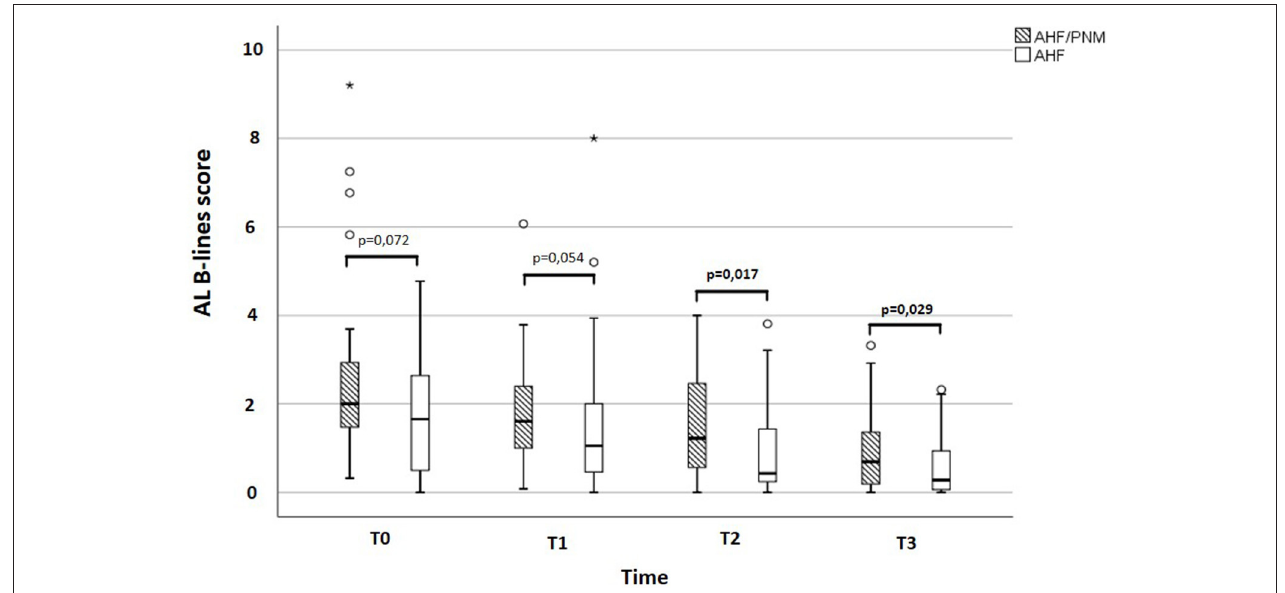
FIGURE 1 | Difference in AL B-lines score at each time point between AHF/PNM and AHF patients. Box and whisker graph describing the difference in AL B-lines score between AHF/PNM and AHF patients. POST, posterior; AHF, isolated acute heart failure; AHF/PNM, acute heart failure with concomitant pneumonia; PNM,